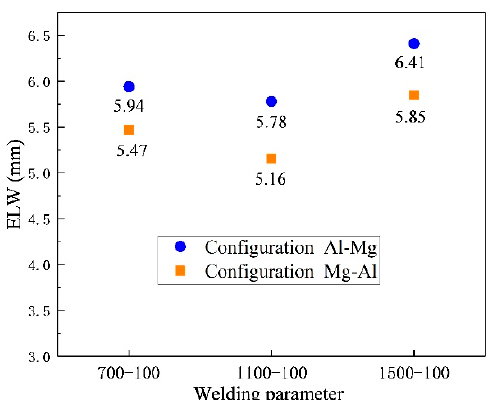
Figure 4. Effective lap width of joints welded in different lap configurations at different rotation speeds.